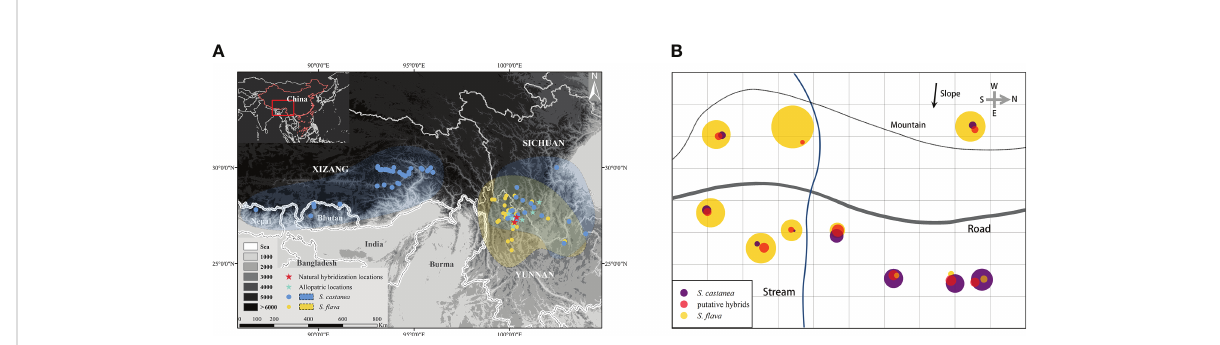
FIGURE 1 Geographical distribution of S . fl ava and S . castanea (A) and the habitat distribution of S . fl ava , S . castanea and hybrids in MY (B) . The area of circle represents the number of individuals of the three taxa in the plot. The map image derived from National Platform for Common Geospatial